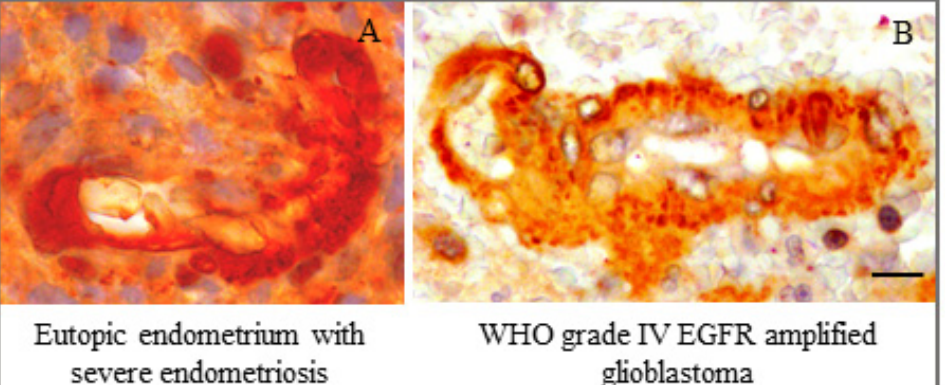
Figure 6. Marked similarity of ErbB-1 expression in the vascular compartment between ( A ) eutopic endometrium obtained on cycle day 24 from a woman with severe ovarian endometriosis-associated infertility and ( B ) a WHO grade IV EGFR-amplified glioblastoma sample. Bar: 10 μ